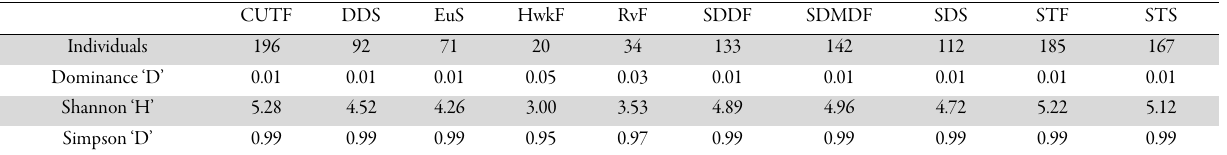
Table 2. Species diversity in different forest